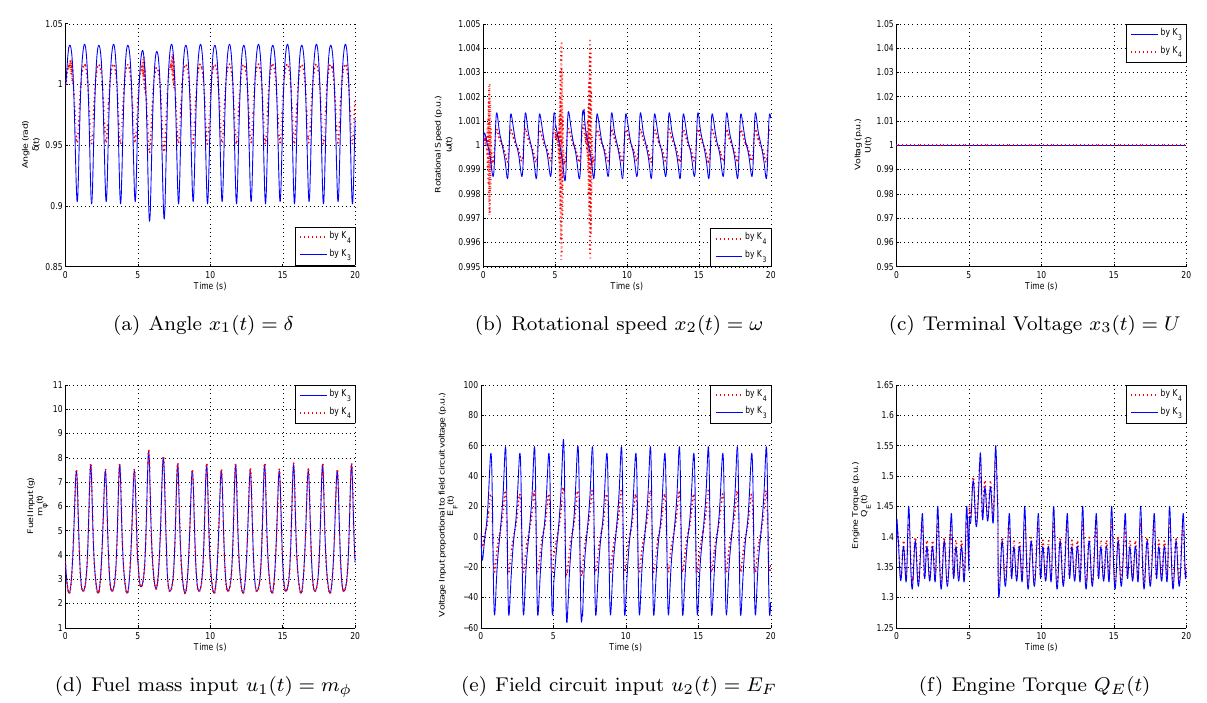
Figure 6: Results of the simulation of the model in eq.(40) with a sudden step in the load torque by the gains: K 3 (solid) and K 4 (dotted) with Θ E modelled as uncertain parameter and time delay of 0.01